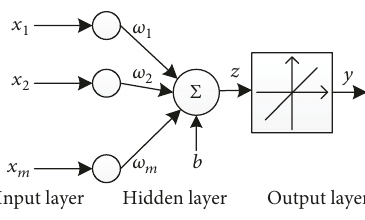
Figure 2: Structure of a linear